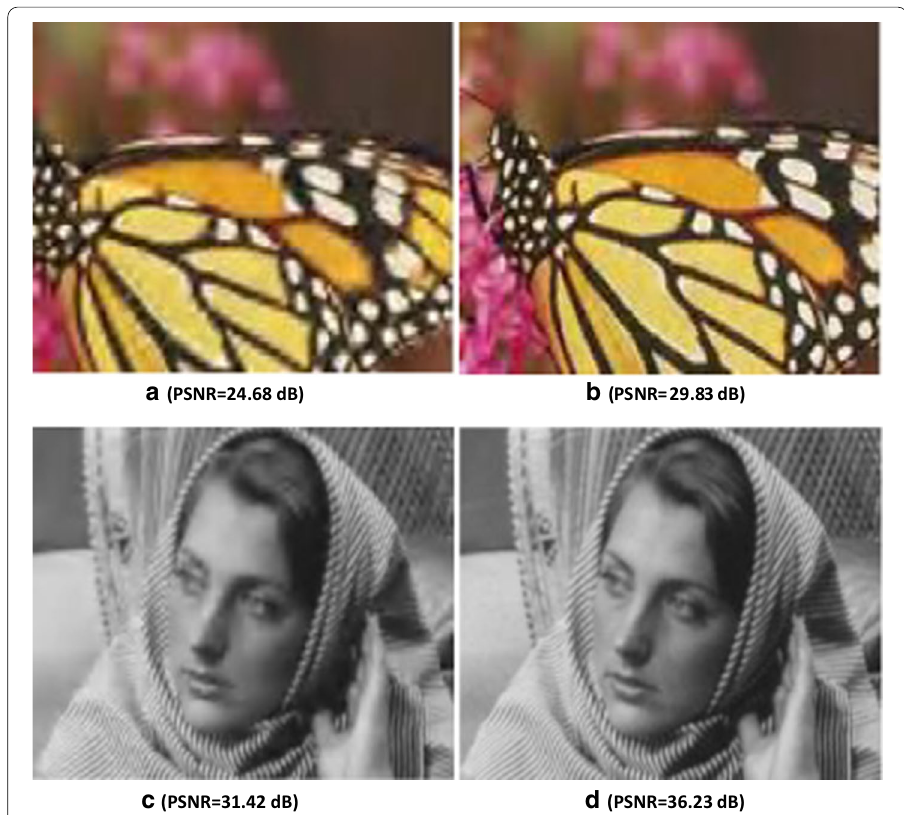
Fig. 16 Visual comparison for Monarch ( a , b ) and Lena ( c , d ). A visual comparison for the transmission of Monarch and Lena images